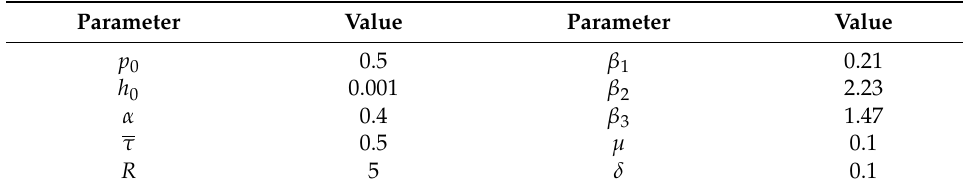
Table 1. The parameters of measurement compensation system.